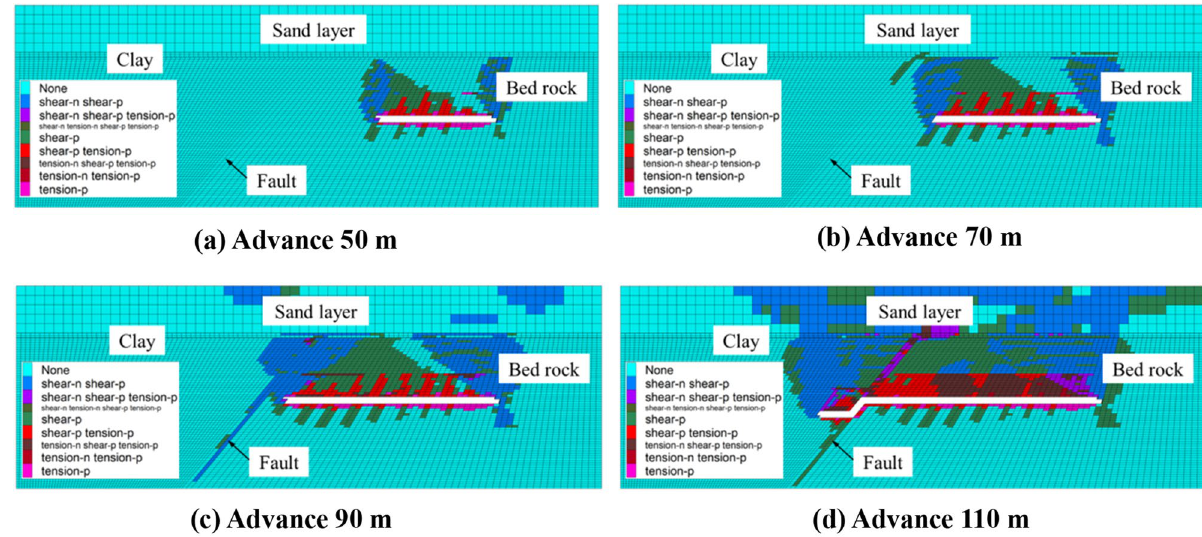
Figure 4. Plastic failure diagram of the model for a bedrock thickness of 20